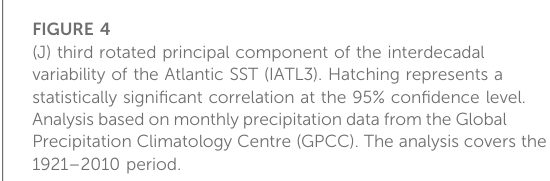
FIGURE 4 (J) third rotated principal component of the interdecadal variability of the Atlantic SST (IATL3). Hatching represents a statistically signi fi cant correlation at the 95% con fi dence level. Analysis based on monthly precipitation data from the Global Precipitation Climatology Centre (GPCC). The analysis covers the 1921 – 2010